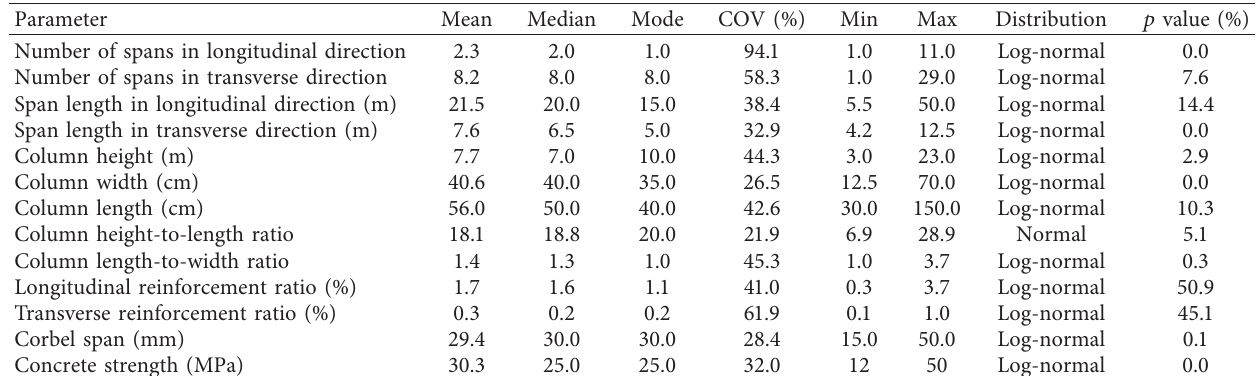
Figure 26: Corbel span in the beam-to-column connections. (a) Histogram probability distributions associated. (b) Corbel span with beam span relation. Table 3: Summary of the distribution properties for the different parameters collected.